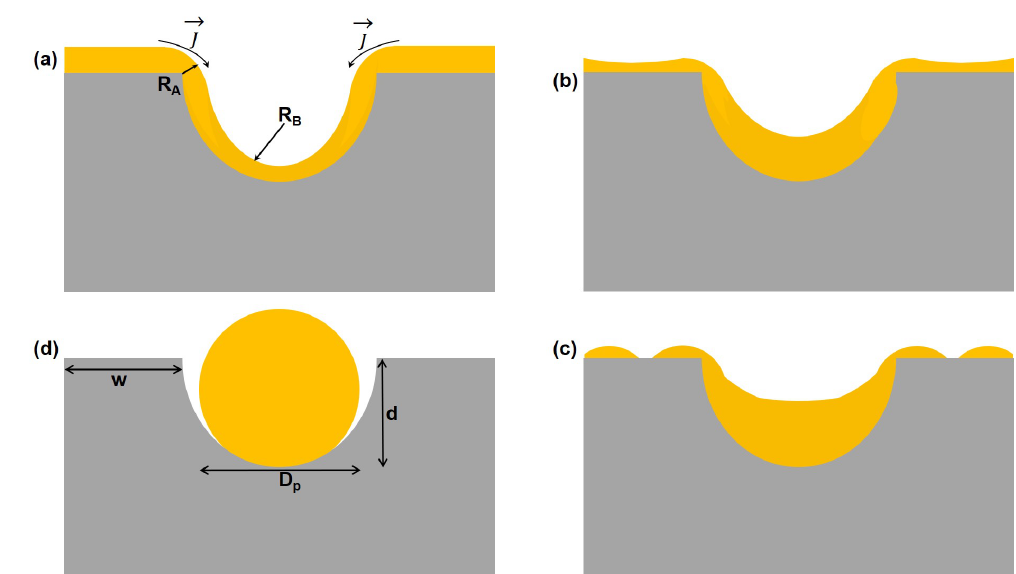
Figure 6. Schematic illustration of curvature-driven evolution of the metal film. ( a ) A conformal film coating the dimpled surface. The curvature at the edge and at the bottom of the dimple is 1/ R A and 1/ R B , respectively; ( b ) The surface diffusion from A to B (shown by arrows in ( a )) is a consequence of the film attempting to minimize the local curvatures as the metal begins to diffuse from the edges into the dimples; ( c ) Breaking up of the metal film on the walls, caused by the flux of atoms into the dimples. ( d ) For thin films and narrow walls, a single particle forms in each dimple.